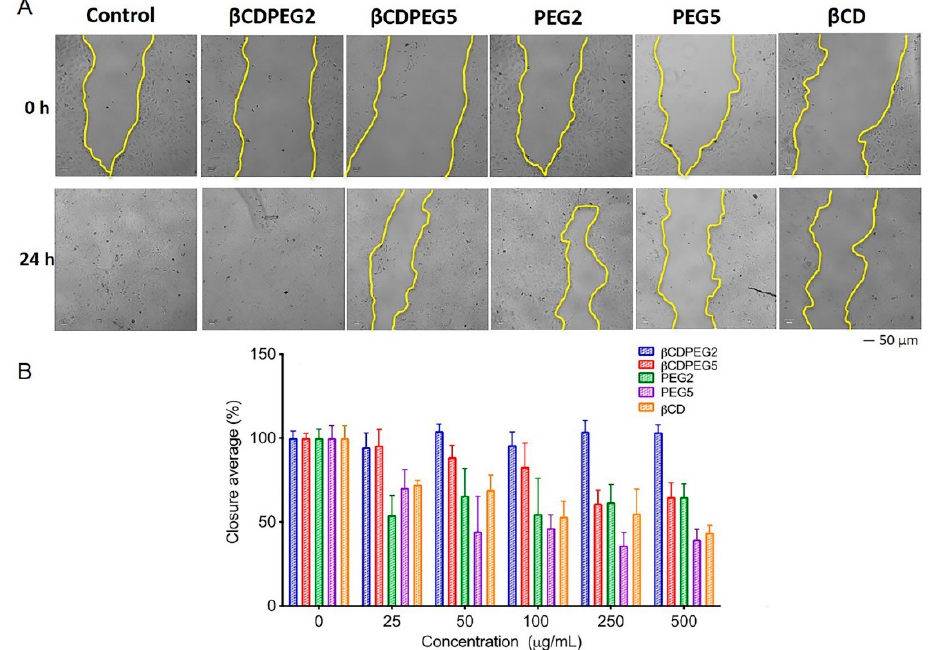
Figure 8. MDCK cell migration in the presence of β CDPEGs, β CD, and PEGs. A scratch was made through the MC3T3-E1 cell layer, and then cells were cultured in the presence of different concentrations of β CDPEGs, β CD, and PEGs (25, 50, 100, 250 and 500 µg/mL) for 24 h. ( A ) Representative images of migration assay of the compounds at 500 µg/mL after the scratch (0 h) and at 24 h later showing the gap closure (area between the two yellow lines); the images were captured at the same scale with a scale bar of 50 µm. ( B ) Area between the two dotted lines expressed as the percentage of cell closure relative to the control.